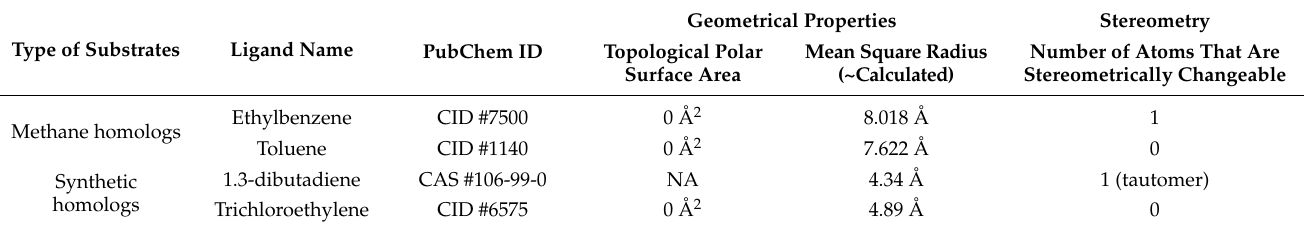
Table 1. The chemical IDs of the natural substrates and nonnatural substrates used in the